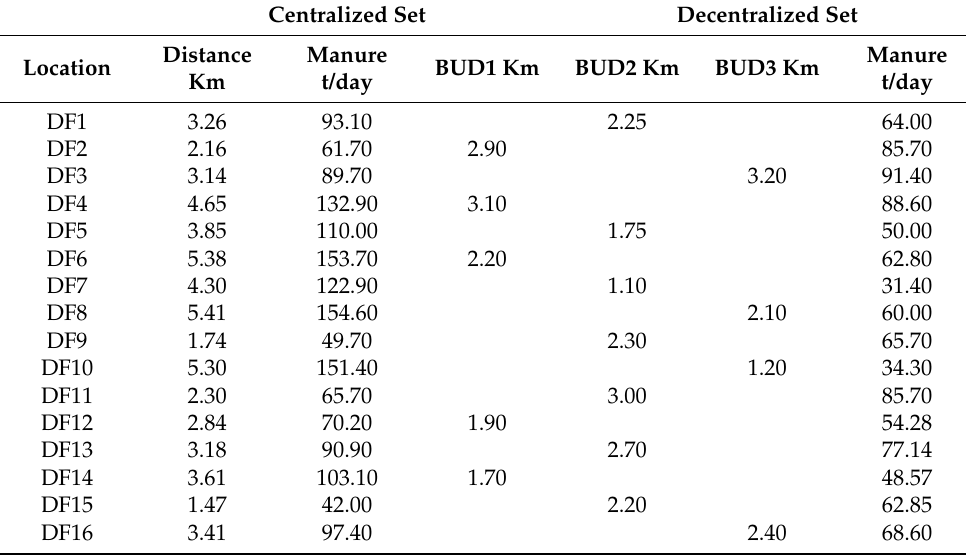
Table 6. Manure transport distance from each livestock producer to each bioenergy unit. Centralized